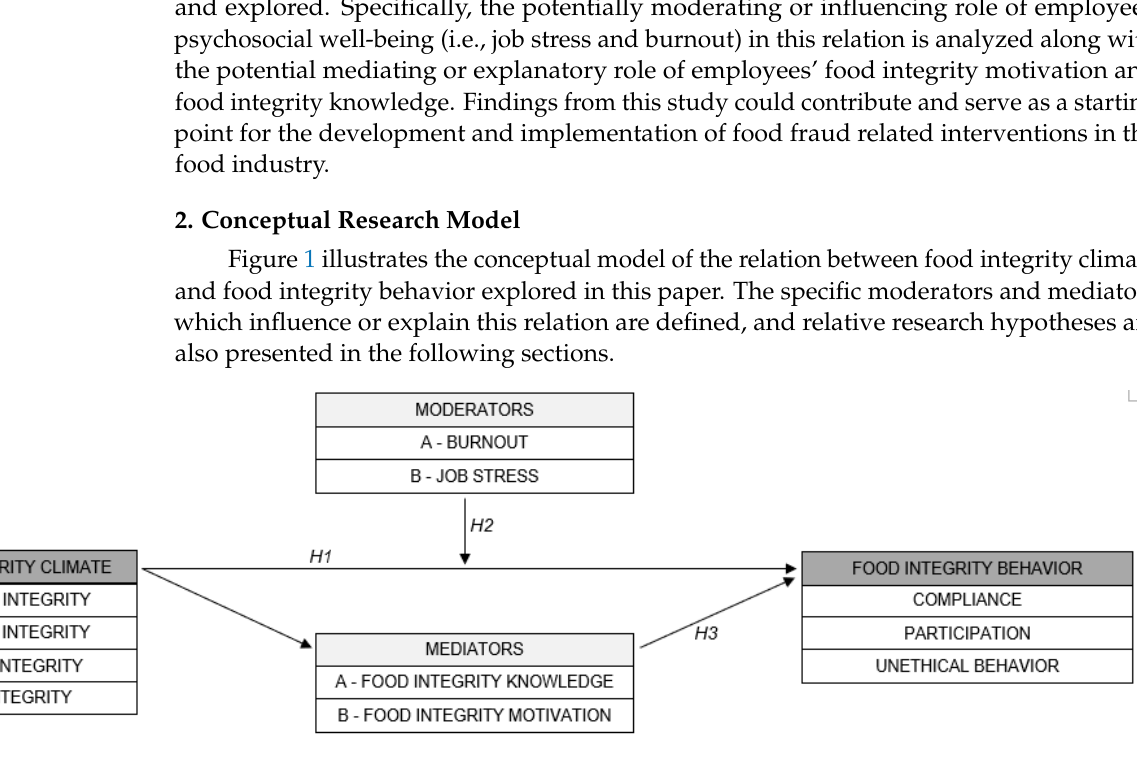
Figure 1. Conceptual model of the relation between food integrity climate and food integrity behav ‐ ior. The food integrity climate as well as the moderators and mediators represent the continuous independent variables, while food integrity behavior is the continuous dependent variable of the study. It is assumed that food integrity climate is positively related to food integrity behavior (Hy ‐ pothesis 1 ( H1 )), that burnout and job stress moderate the relation between food integrity climate and food integrity behavior (Hypothesis 2A and 2B ( H2 )) and that food integrity knowledge and motivation mediate the relation between food integrity climate and food integrity behavior (Hy ‐ pothesis 3A and 3B ( H3 )).